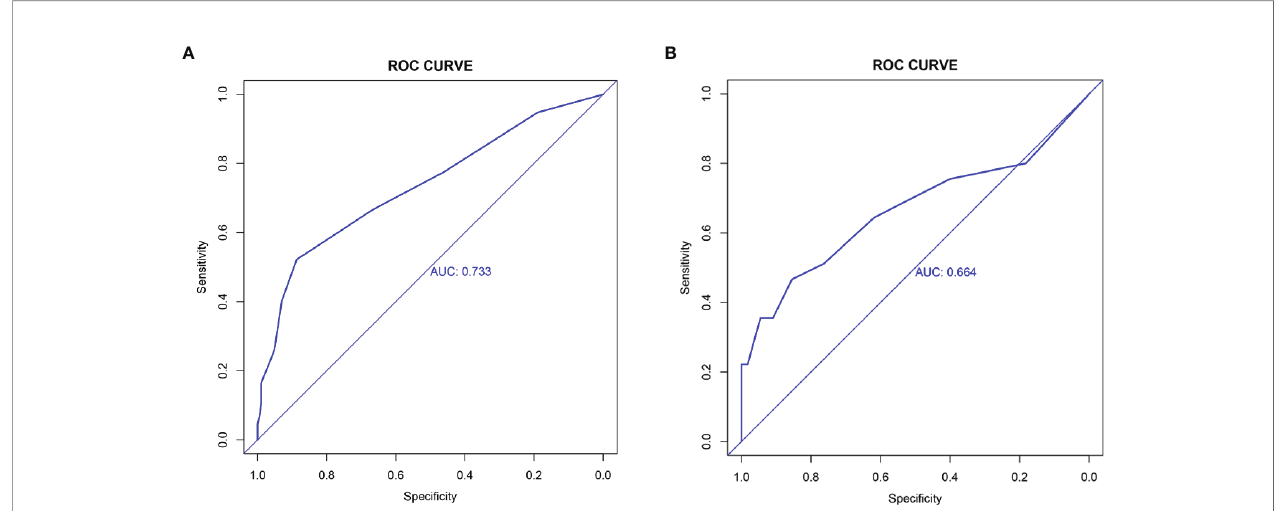
FIGURE 2 | Receiver operating characteristics (ROC) analysis in (A) training data set; (B) external validation data set. The AUC for the nomogram in the training data set is 0.733, while for the external validation data set is